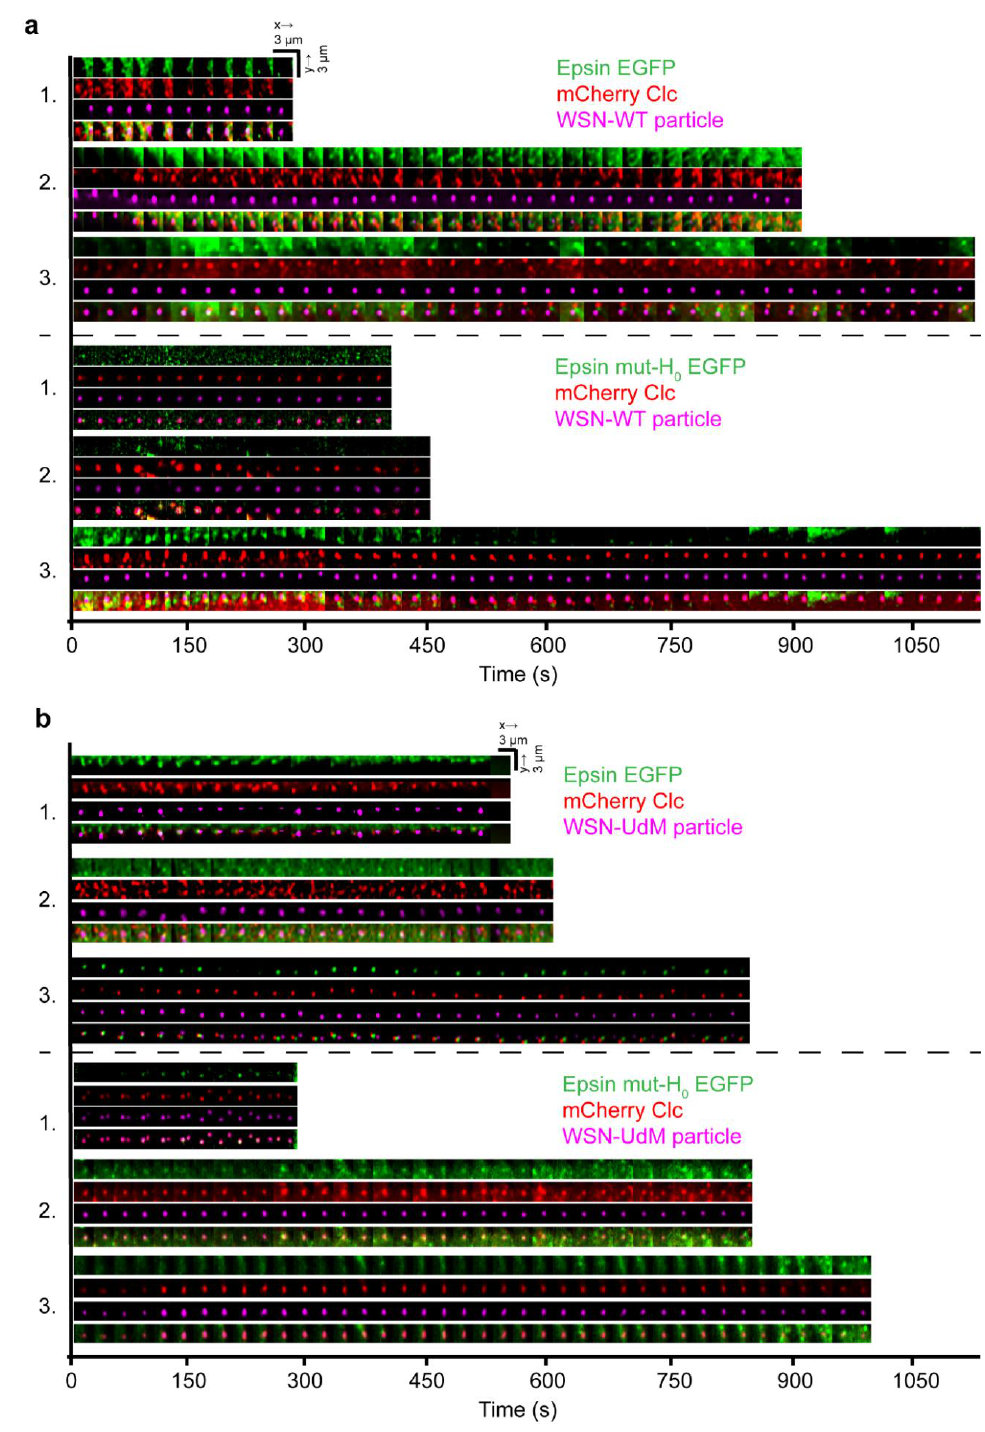
Figure 5. Both spherical and filament-forming IAVs co-localize and internalize via CCSs. ( a ) Three example trajectories of IAV (magenta) internalization in x-y and x-z spatial orientations. Time lapse montages of WSN-WT particles co-localizing with epsin-EGFP and mCherry-Clc (top panel) and epsin mut-H 0 EGFP and mCherry-Clc (bottom panel). ( b ) Time lapse montages of WSN-UdM particles co-localizing with epsin-EGFP and mCherry-Clc (top panel) and epsin mut-H 0 EGFP and mCherry-Clc (bottom